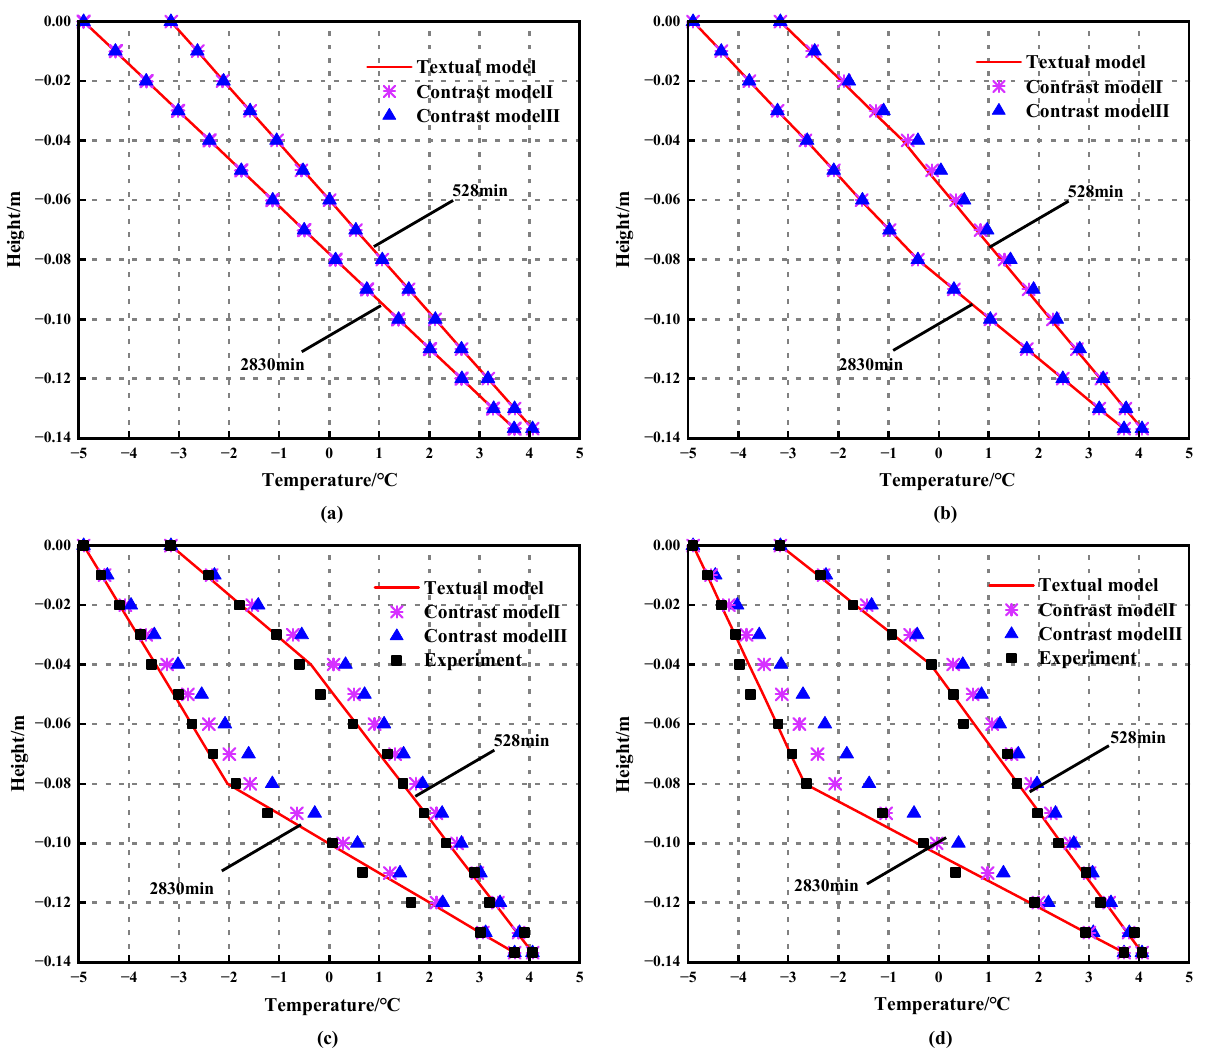
Figure 8. Temperature field with different initial saturation. ( a ) S = 0.2; ( b ) S = 0.35; ( c ) S = 0.65; ( d ) S = 0.8.